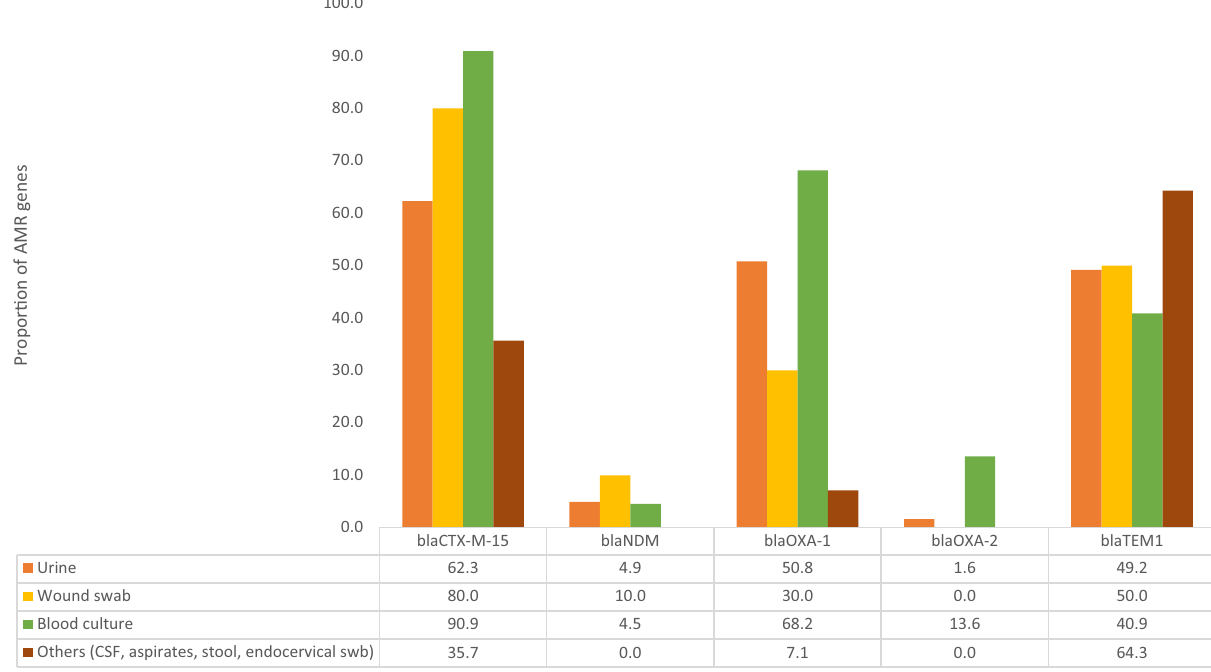
Figure 3. Comparison of ESBL and Carbapenem AMR genes distribution based on clinical specimens expressed in